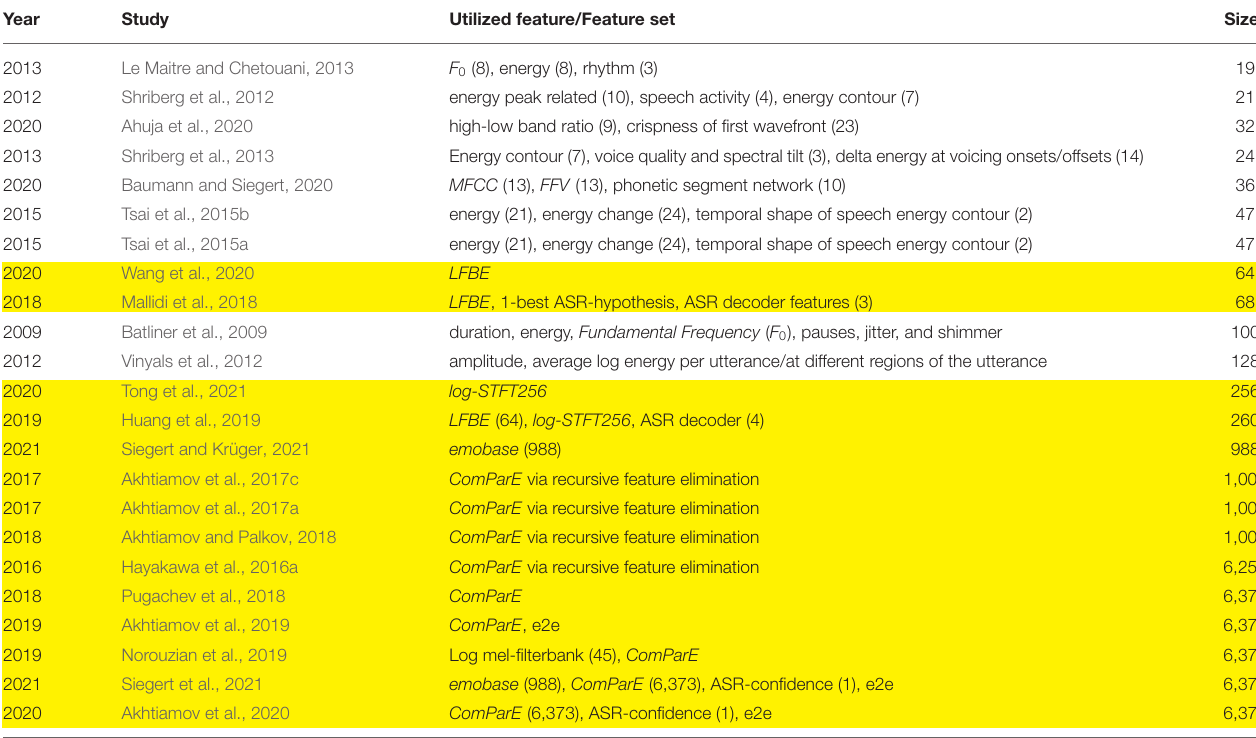
TABLE 4 | Overview of utilized features/feature sets for each identified